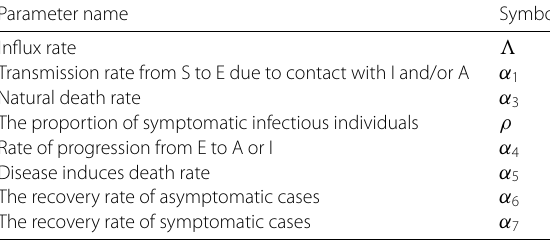
Table 1 The parameters and their descriptions Parameter name Symbol Influx rate (cid:5) Transmission rate from S to E due to contact with I and/or